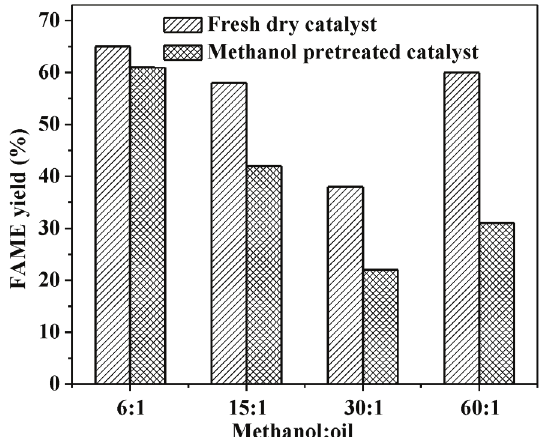
Fig. 4 – Effect of catalyst pretreatment on FAME yield from Karanja oil for different methanol to oil ratios. Reaction condi- tions: catalyst amount = 18 wt% of oil; temperature= 393 K; rpm = 750; reaction mixture volume = 341